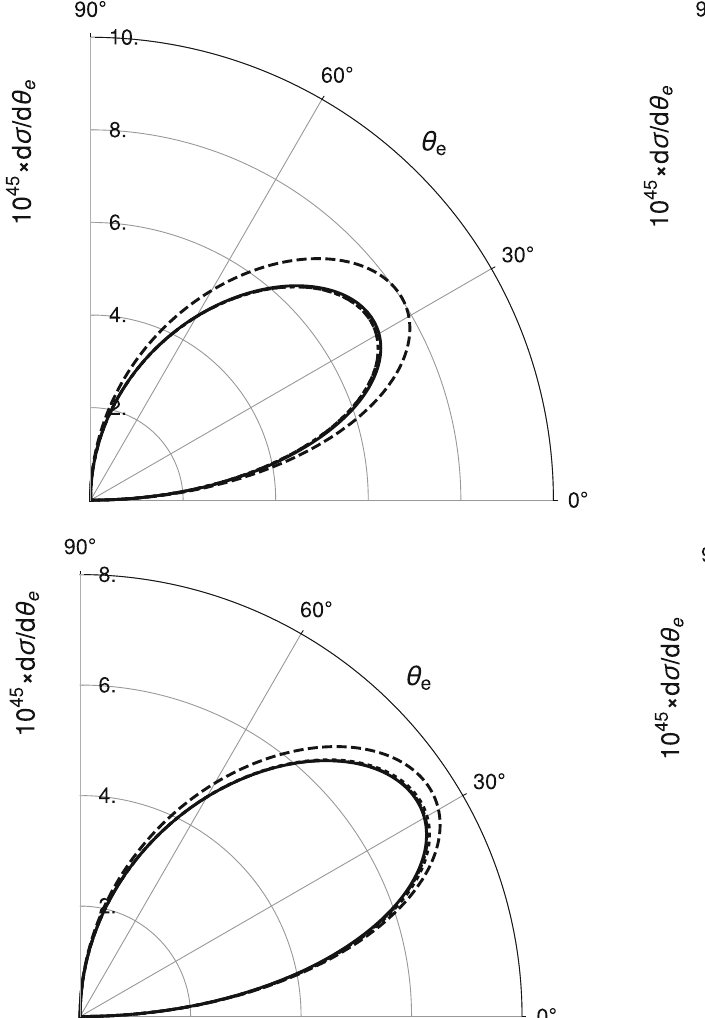
Fig. 8 Plot of d σ/ d θ e as a function of θ e for ˆ η ν · ˆ q = − 0 . 95, E ν = 1MeV, φ ν = 0. Upper plot for TRSC: standard V − A interaction (solid line); the combination of V − A and T R when | c R (dashed line); the case of V − A and S R when | c R (dottedline); V − A with P R when | c R line). Lower plot for TRSV: standard V − A interaction (solid line); the combination of V − A and T R when | c R line); the case of V − A and S R when | c R line); V − A with P R when | c R line)